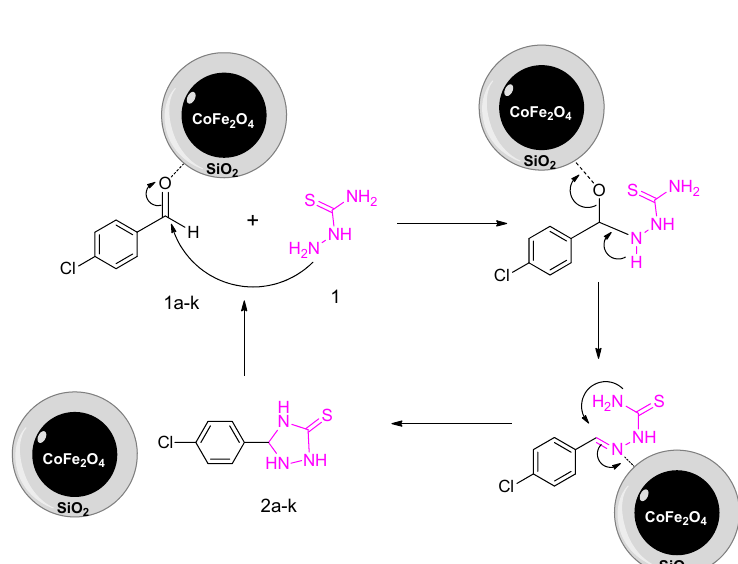
Scheme 1. Plausible mechanism for the conversion of 5-(4chlorophenyl)-1,2,4-triazolidine-3-thione from 4-chloro benzaldehyde and